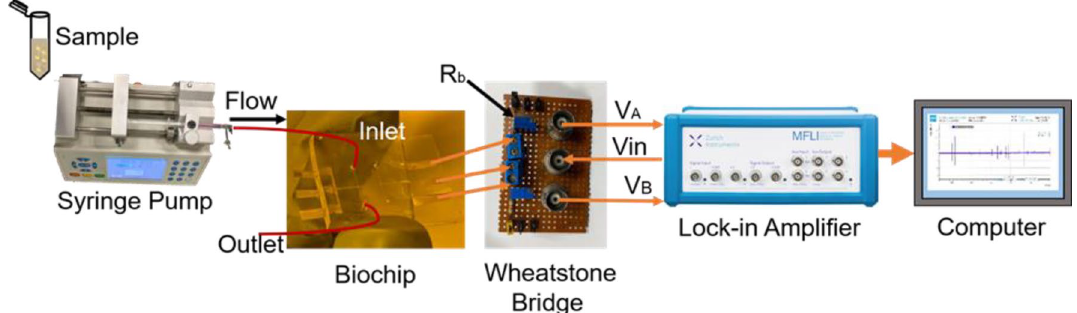
Figure 5. The experimental setup schematic represents syringe pump, flexible biochip, Wheatstone bridge, lock-in amplifier, and computer-aided software for data